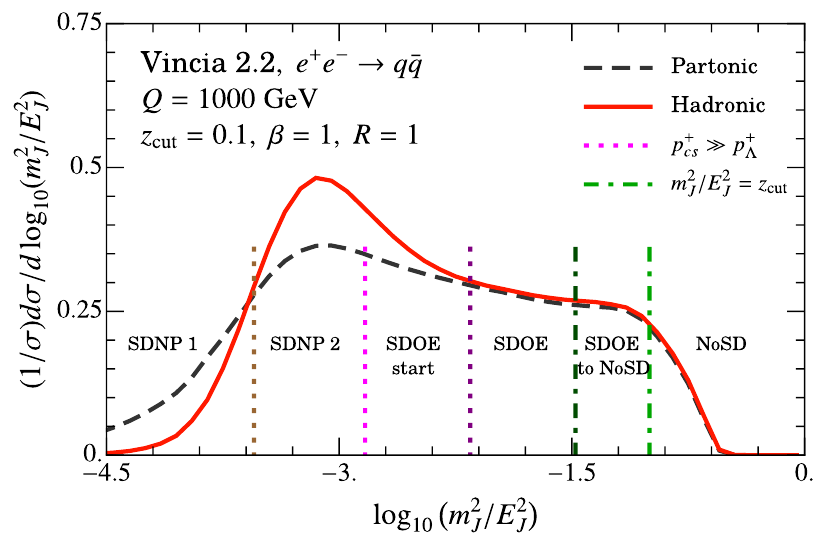
Figure 19 . Vincia prediction for m 2 spond to the di(cid:11)erent panels shown in (cid:12)gure 18. Here the inequality (cid:29) is replaced by a factor of